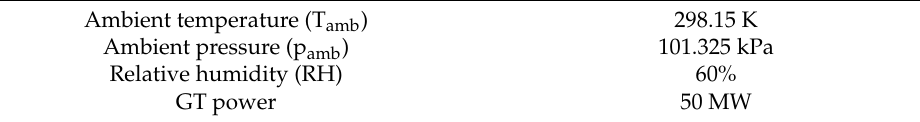
Table 1. Reference conditions for the gas turbine